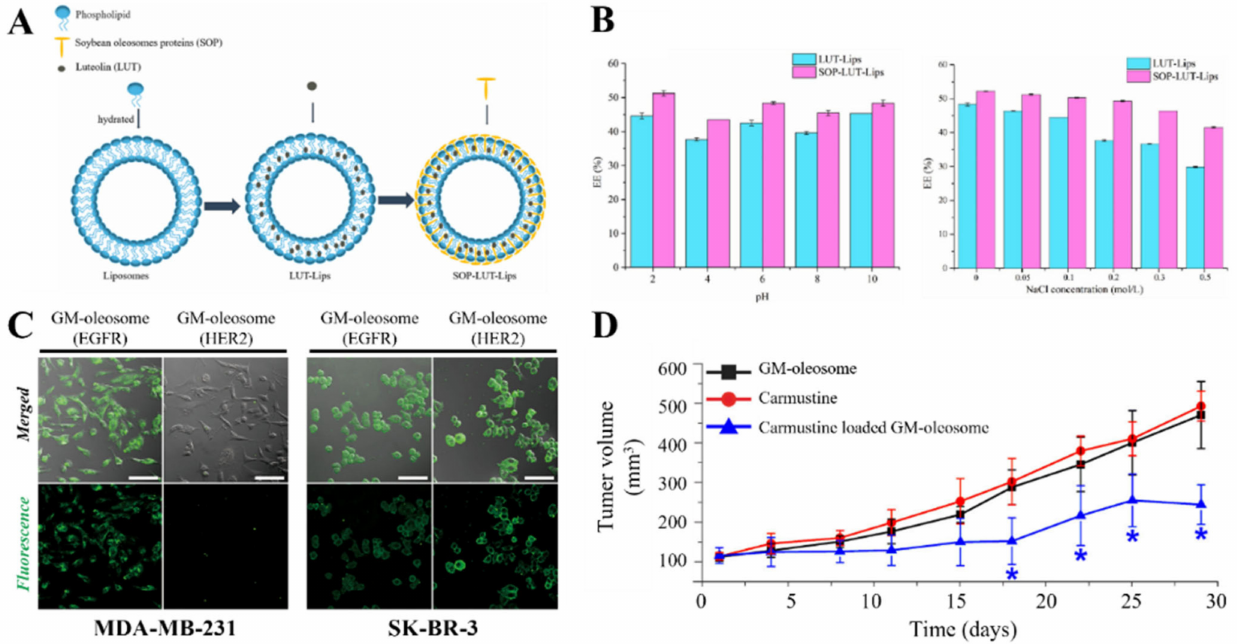
Figure 7. Functionalization of liposome and LNPs coated with surfactant protein. ( A ) Schematic illustration of the formation of luteolin-loaded liposomes coated with soybean oleosin (SOP-LUT- Lips). ( B ) Encapsulation efficiency of LUT-Lip and SOP-LUT-Lip under different pH conditions and ionic strength conditions. ( C ) Selectivity test of GM-oleosome. EGFR is not specific for either breast cancer cell line. However, HER2 is selective for SK-BR-3. Observation was conducted via confocal microscopy. Scale bar is 100 µ m. ( D ) Increased carmustine delivery capacity of GM-oleosome (* p < 0.001 compared to G2 and G3). Reproduced with permission from [135], published by Elsevier, 2022, and [50] published by the American Chemical Society,